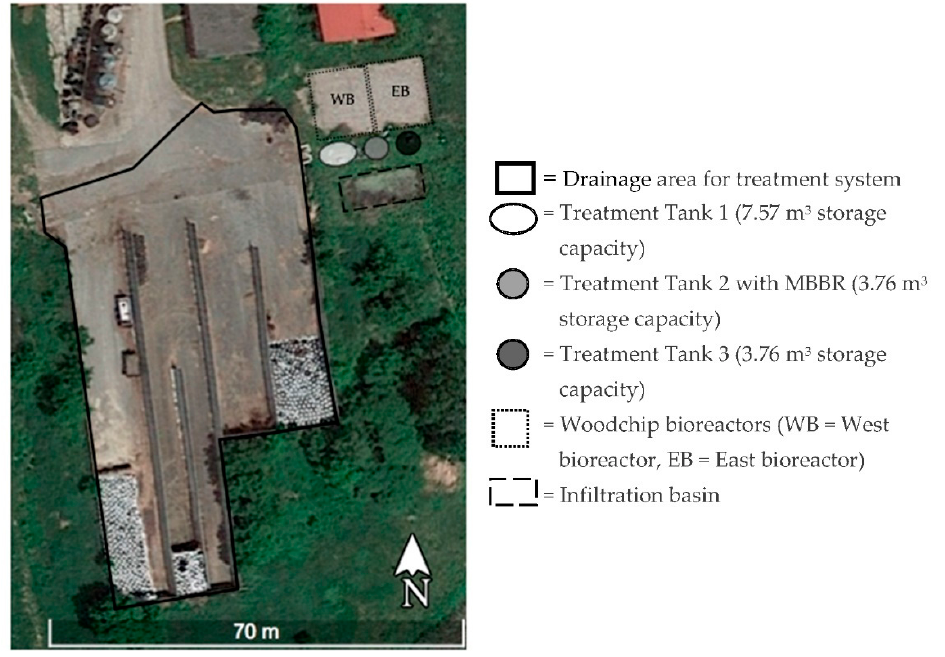
Figure 1. Plan view of the silage bunker runoff treatment system located east of the silage storage bunkers. Treatment tanks are enlarged to show underground location.